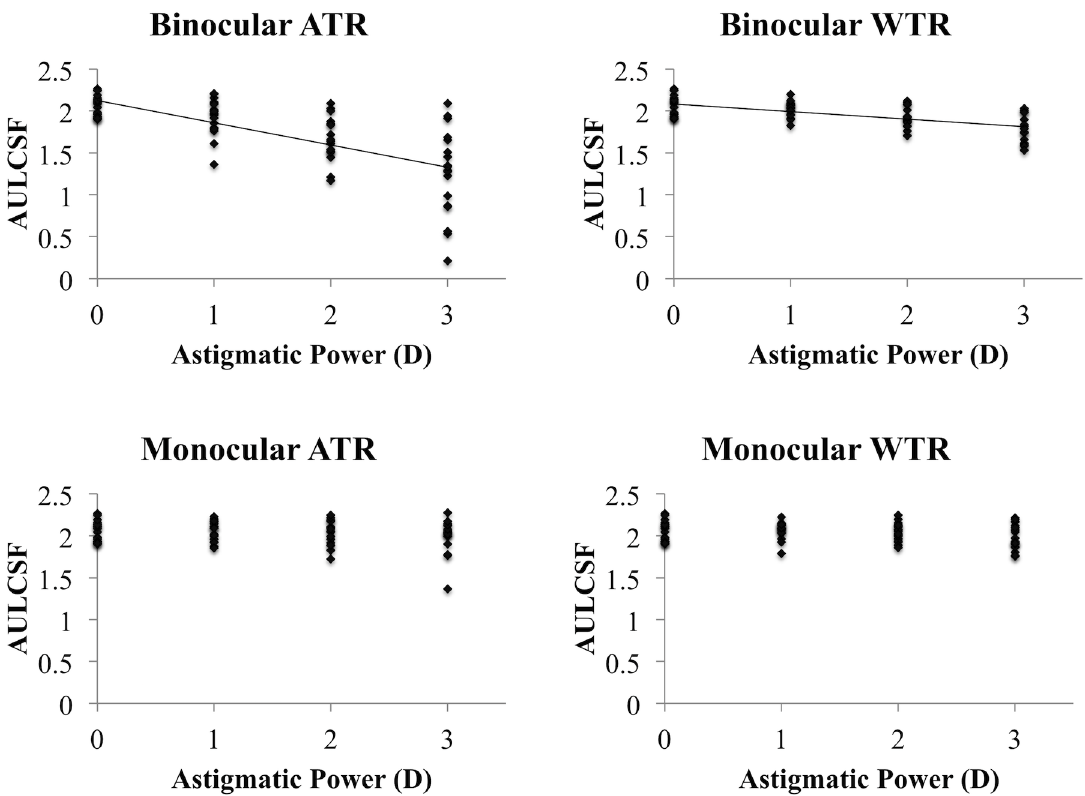
Fig 1. Relationship between astigmatic powers and contrast sensitivity (CS). In binocular astigmatism, area under the log contrast sensitivity function (AULCSF) decreased as astigmatic power increased (P < 0.0001, Spearman correlation test). In contrast, astigmatic power did not affect AULCSF in monocular astigmatism. (ATR = against-the-rule, WTR = with-the-rule).